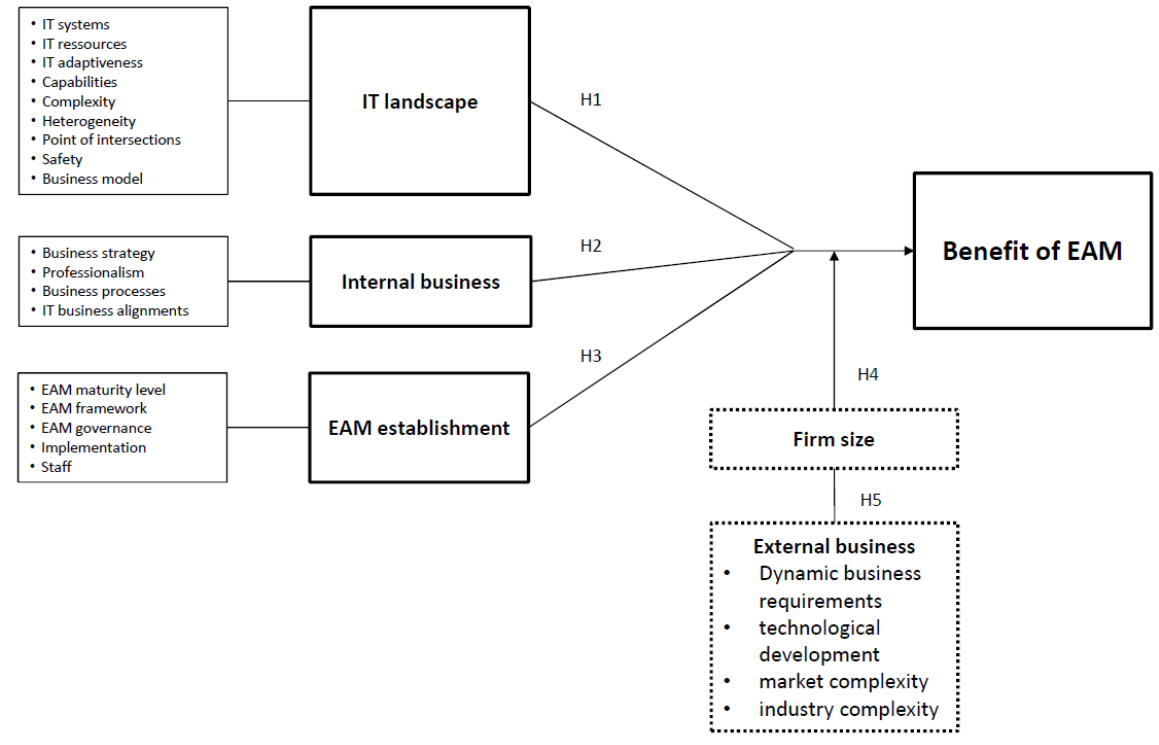
Figure 1. Research Model according to Reichstein et al. 2019